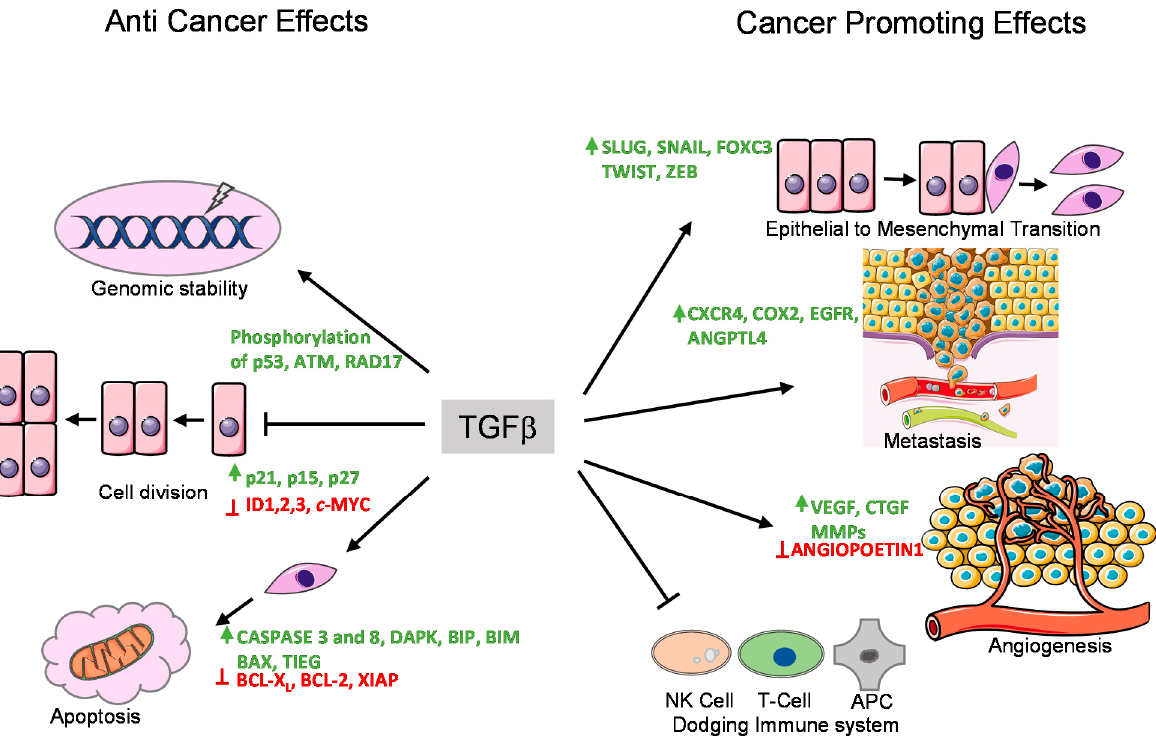
Figure 2. Tumor suppressor and promoting effects of the TGF β pathway. TGF β exerts its anti-tumor and tumor promoting effects by regulating the expression of various target genes. These functions are performed by various means shown with arrows. The genes whose expression are enhanced by TGF β are shown in green, whereas the genes whose expression are suppressed by TGF β are marked in red.